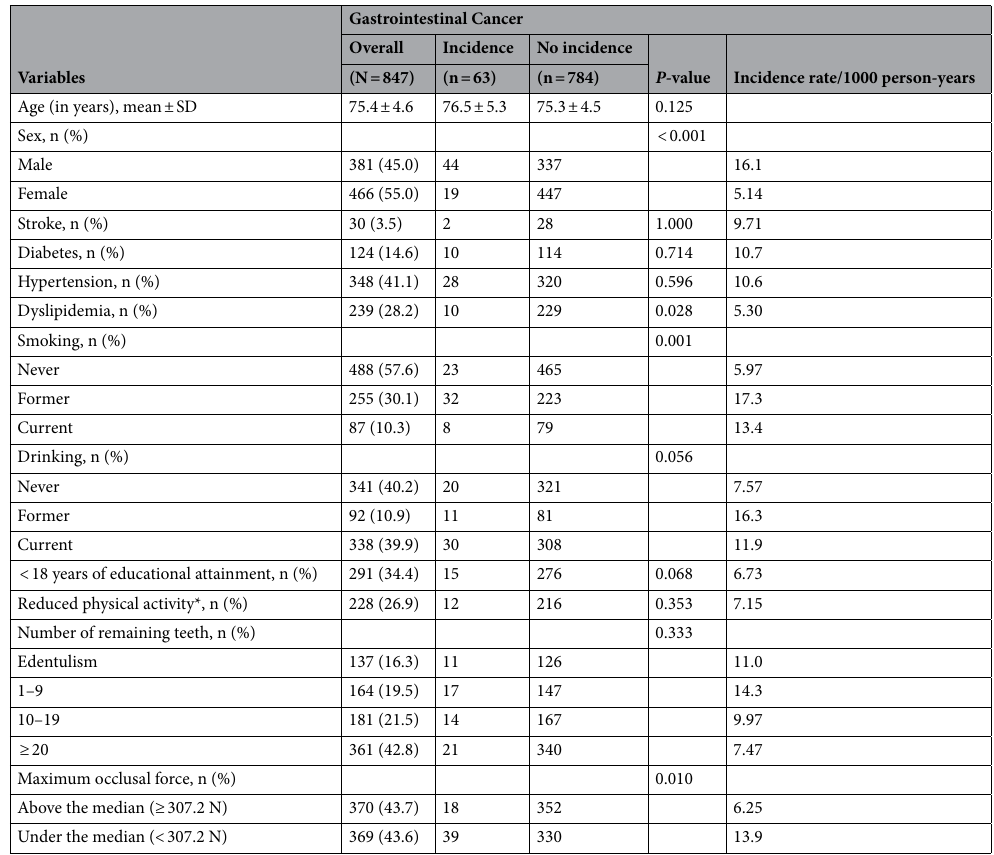
Table 1. Baseline characteristics based on the incidence of gastrointestinal cancer. Smoking, n = 830; Drinking, n = 771; < 18 years of educational attainment, n = 809; Reduced physical activity, n = 844. P -values were obtained using the Wilcoxon rank-sum test for continuous variables and Fisher’s exact test for categorical variables. SD standard deviation. *Medical Outcome Study score below